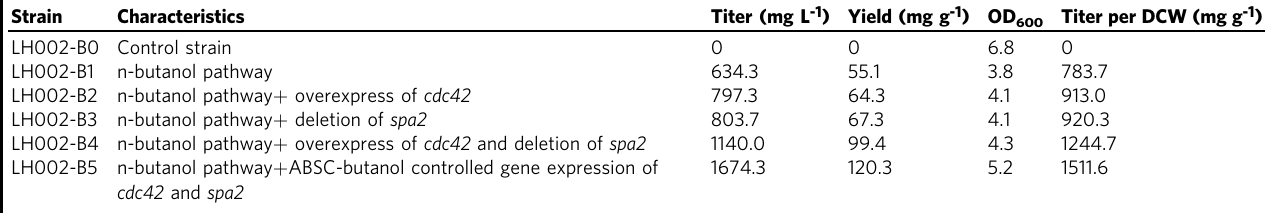
Table 1 Differences in control strain and engineered S. cerevisiae on n-butanol production. Strain